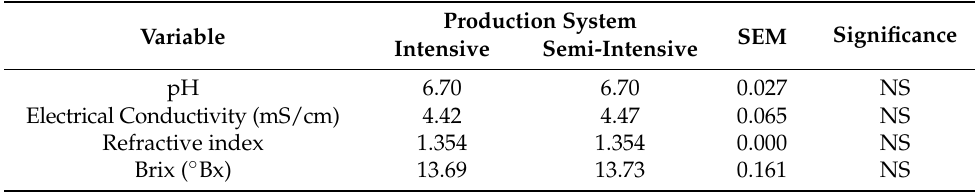
Table 2. Effect of the production system on sheep milk physical